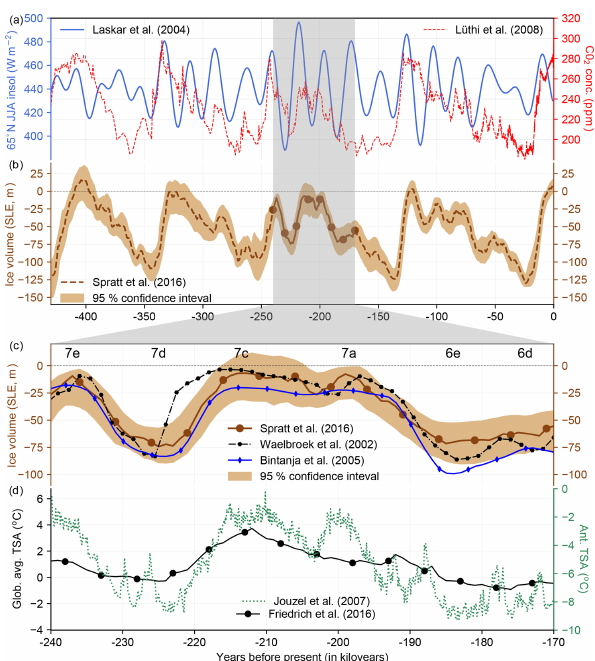
Figure 1. Overview of the forcings and reconstructions relevant to this study. From top to bottom: (a) summer insolation at 65 ◦ N (Wm − 2 ; blue; Laskar et al., 2004) and CO 2 concentration (ppm; red; Lüthi et al., 2008) over the last 430ka; (b) sea level recon- structions (m) along with 95% confidence limits from Spratt and Lisiecki (2016) (brown) since the Mid-Brunhes Event. Notice the relatively cold MIS 7; (c) sea level reconstructions (m) from Spratt and Lisiecki (2016) (brown), Waelbroeck et al. (2002) (black), and Bintanja et al. (2005) (blue) over MIS 7 (240–170ka); (d) global average surface air temperature anomaly reconstructed from prox- ies ( ◦ C; black; Friedrich et al., 2016) and Antarctic temperature anomaly relative to present day ( ◦ C; green; Jouzel et al., 2007). The lettering convention of MIS substages as suggested by Railsback et al.